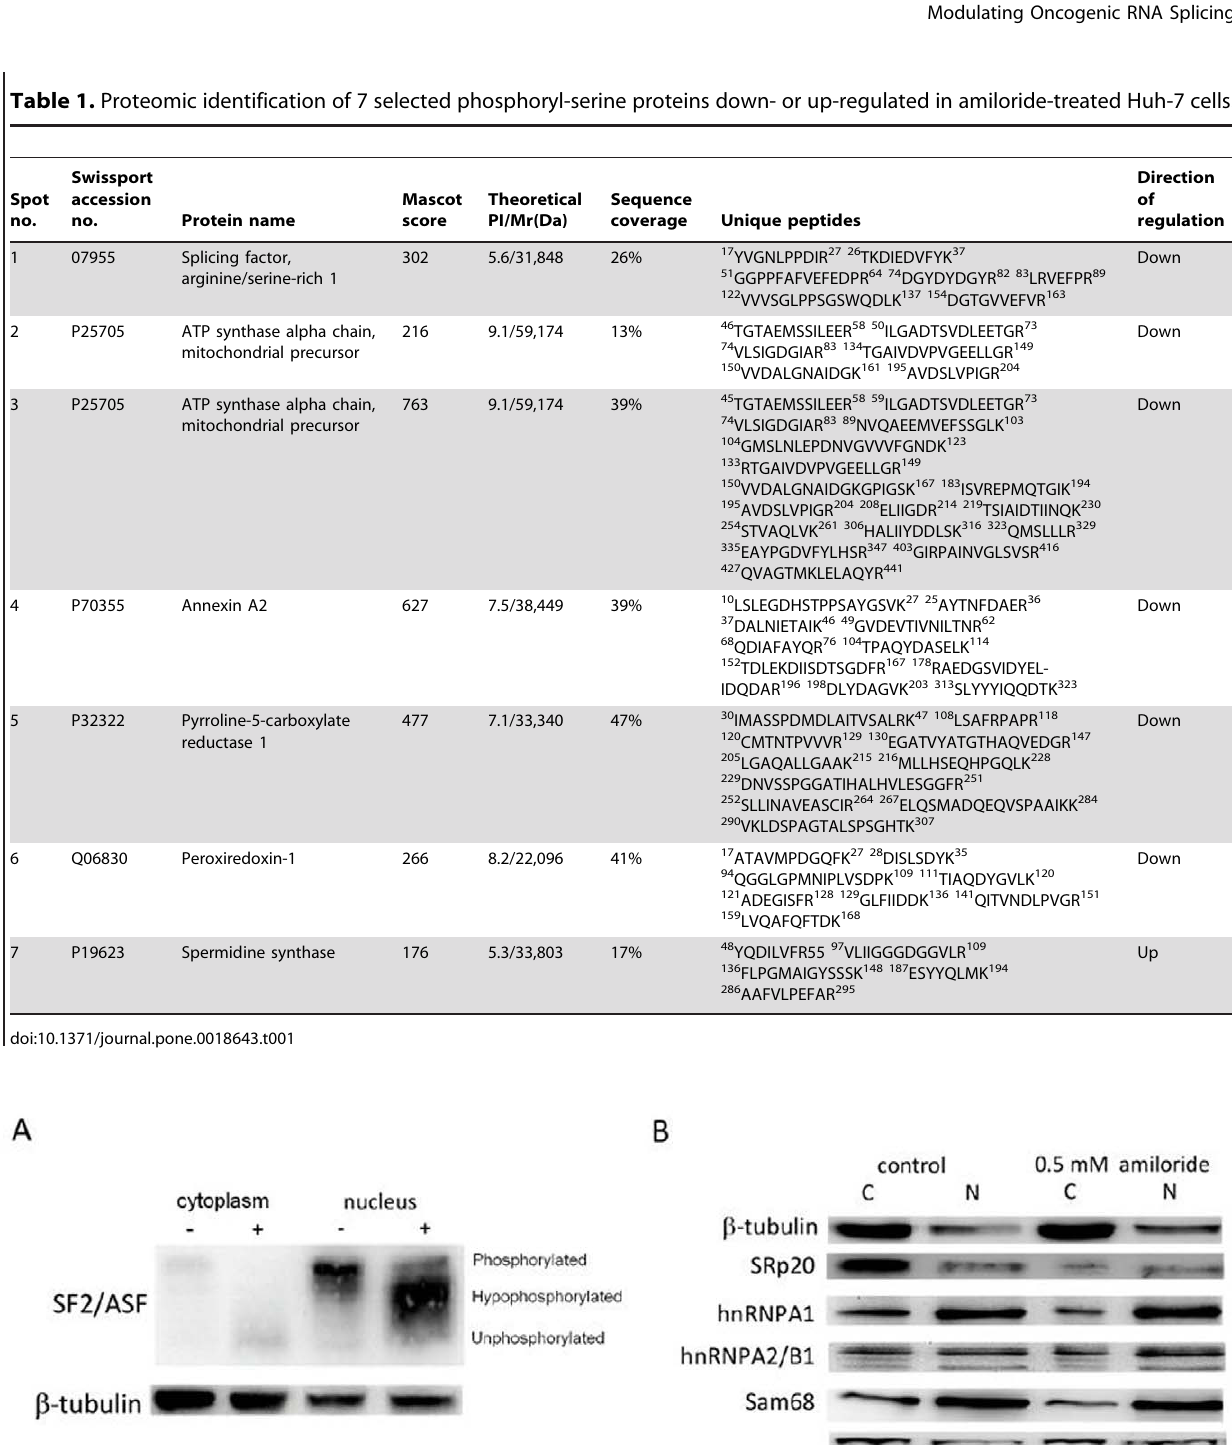
Table 1. Proteomic identification of 7 selected phosphoryl-serine proteins down- or up-regulated in amiloride-treated Huh-7 cells.